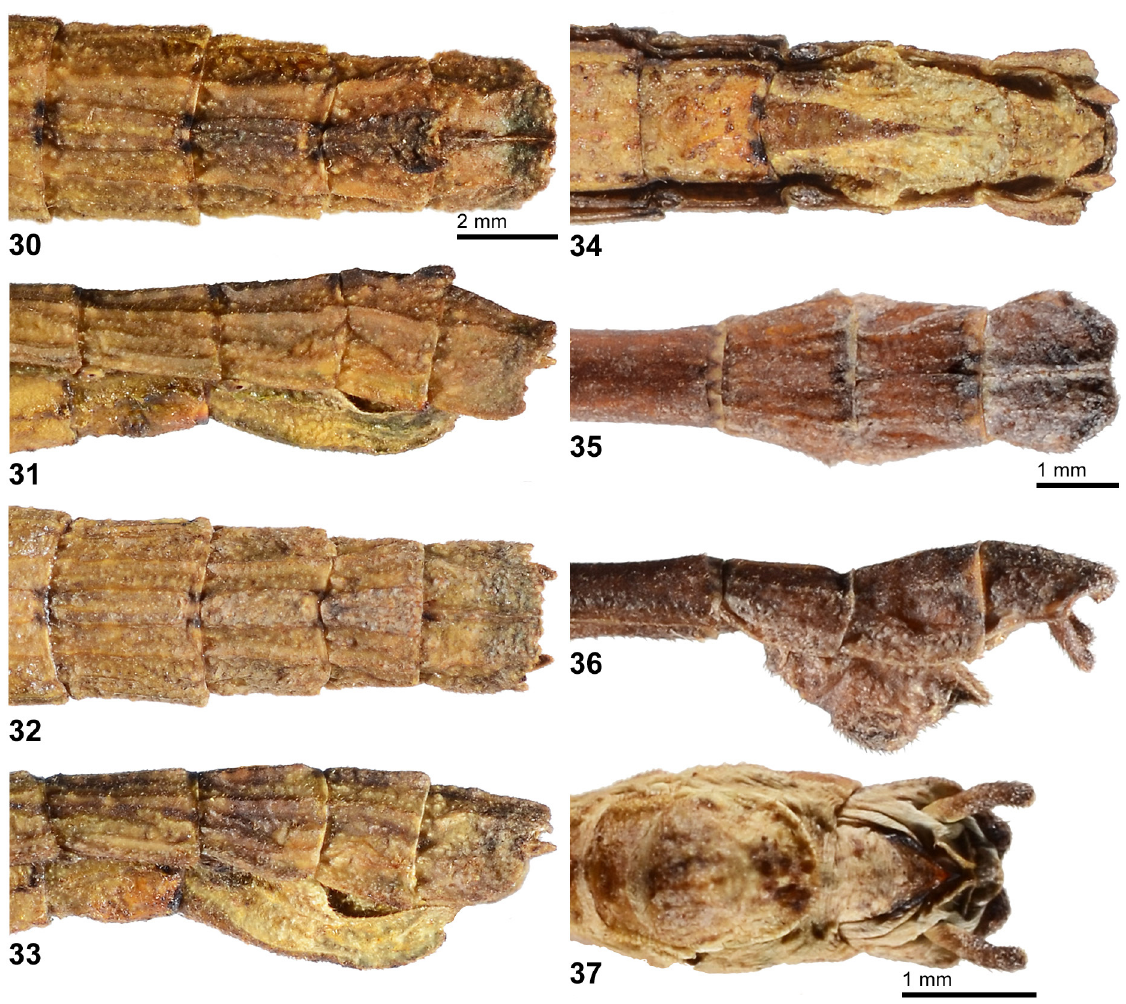
Figs 30–37. Lobolibethra pozuzoae sp. nov. 30 . ♀, PT: apex of abdomen in dorsal view (FH, 0631-41). 31 . ♀, PT: apex of abdomen in lateral view (FH, 0631-41). 32 . ♀, PT: apex of abdomen in dorsal view (FH, 0631-44). 33 . ♀, PT: apex of abdomen in lateral view (FH, 0631-44). 34 . ♀, PT: apex of